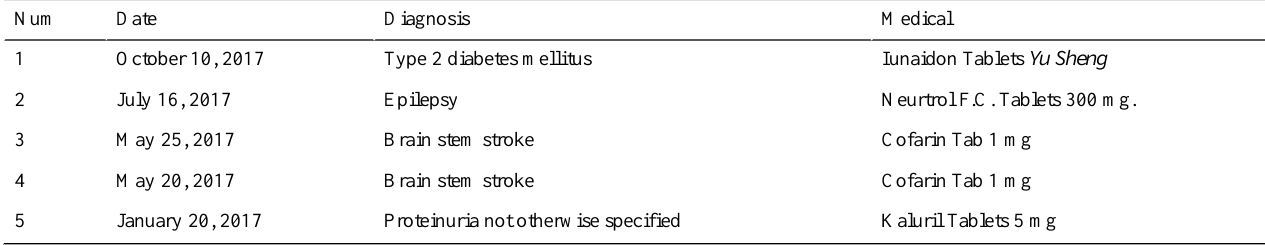
Table 1. The data of testing scenario for international personal health record exchange.